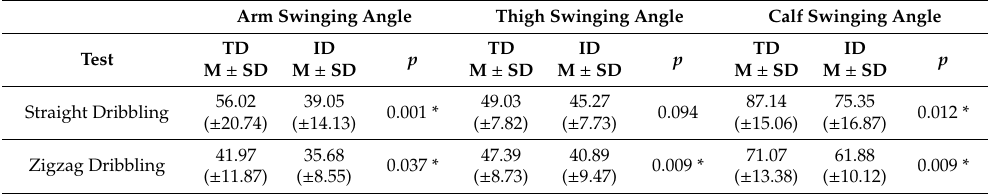
Table 11. ANOVA results of limb (arm, thigh, and calf) swinging angle in the two groups. Arm Swinging Angle Thigh Swinging Angle Calf Swinging